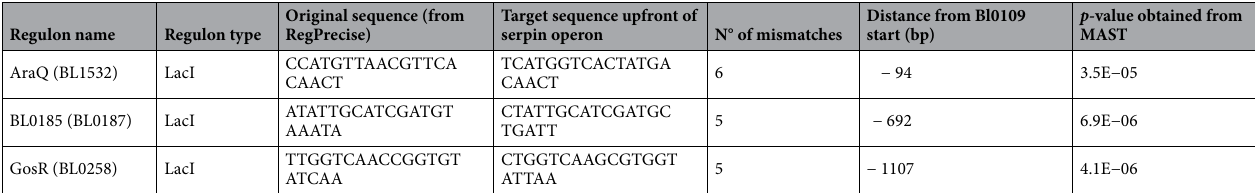
Table 1. List of transcription factor binding sites predicted by MAST upfront the promoter region of the BL0109 gene.